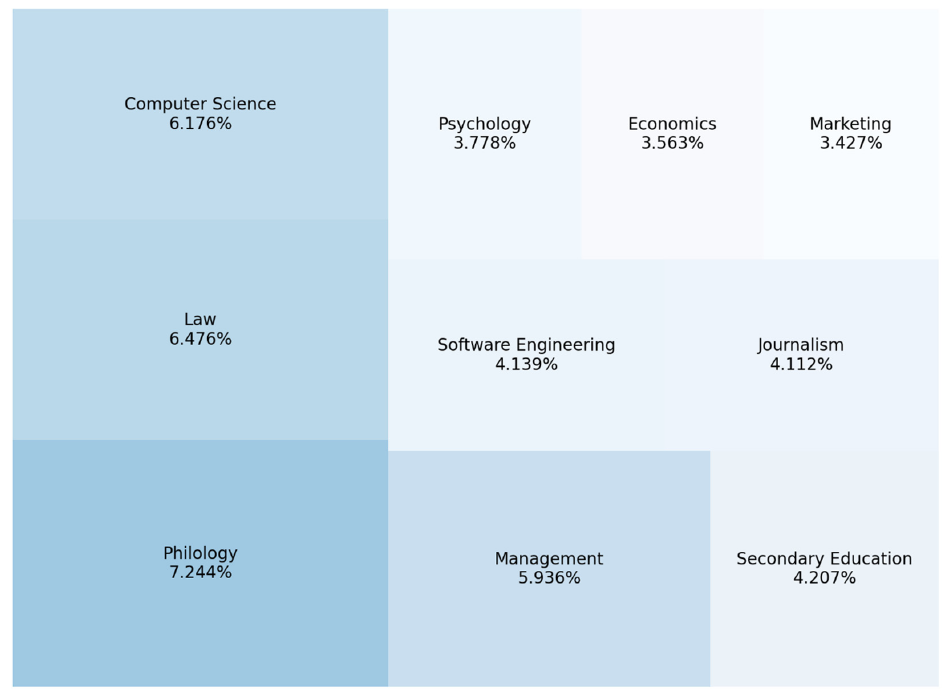
Figure 4. Top 10 most popular specialties among entrants during the 2021 admission campaign.